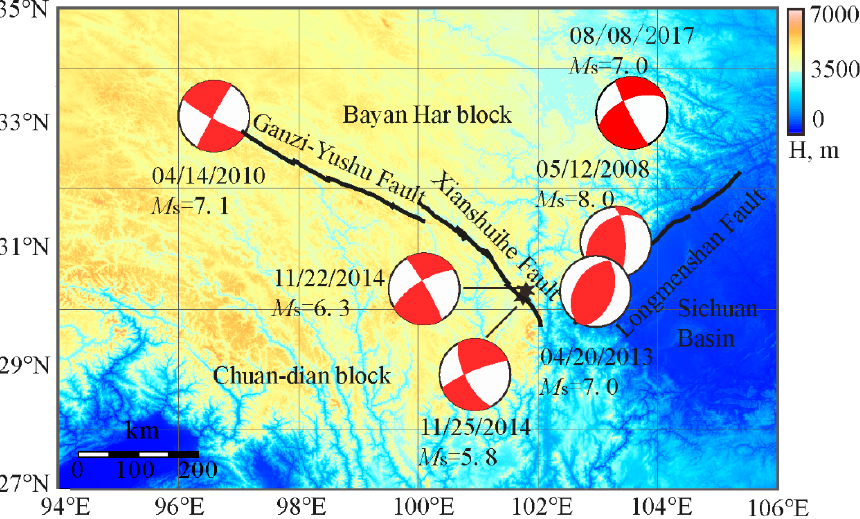
Figure 1. Topographic map including the distribution of the 2008 Ms 8.0 great Sichuan (Wenchuan) earthquake and five other large earthquakes. The epicenter loci of the 2008 Wenchuan earthquake and 2013 Ms 7.0 Lushan earthquake are from the USGS, whereas the other epicenter loci (2010 Ms 7.1 Yushu earthquake, 2014 Ms 6.3 and Ms 5.8 Kangding earthquakes, and 2017 Ms 7.0 Jiuzhaigou earthquake) are from the China Earthquake Networks Center (CENC). The focal mechanisms of the Wenchuan and Lushan events are from the Global Centroid Moment Tensor (CMT), that of the Yushu event is from Liu et al. [18], those of the Ms 6.3 and Ms 5.8 Kangding double earthquakes are from Zhang et al. [19], and that of the Ms 7.0 Jiuzhaigou event is from the USGS.